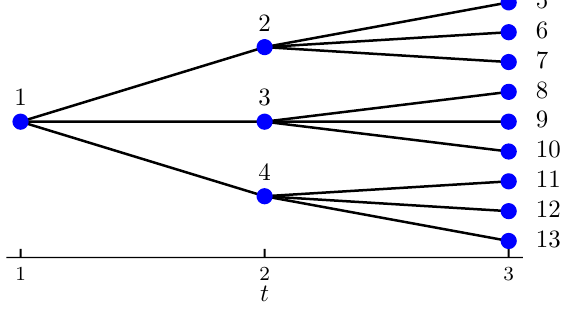
Figure 1. Example of an event tree with T = 3 periods and K = 13 nodes. According to the notation used in this paper, K 1 = { 1 } , K 2 = { 2,3,4 } and K 3 = { 5, . . . ,13 } , where K 3 ≡ K T is the set of leaf nodes. The tree contains S = 9 sample paths, that is, A ( 5 ) = { 1,2,5 } , A ( 6 ) = { 1,2,6 } , A ( 7 ) = { 1,2,7 } , A ( 8 ) = { 1,3,8 } , A ( 9 ) = { 1,3,9 } , A ( 10 ) = { 1,3,10 } , A ( 11 ) = { 1,4,11 } , A ( 12 ) = { 1,4,12 } and A ( 13 ) = { 1,4,13 }